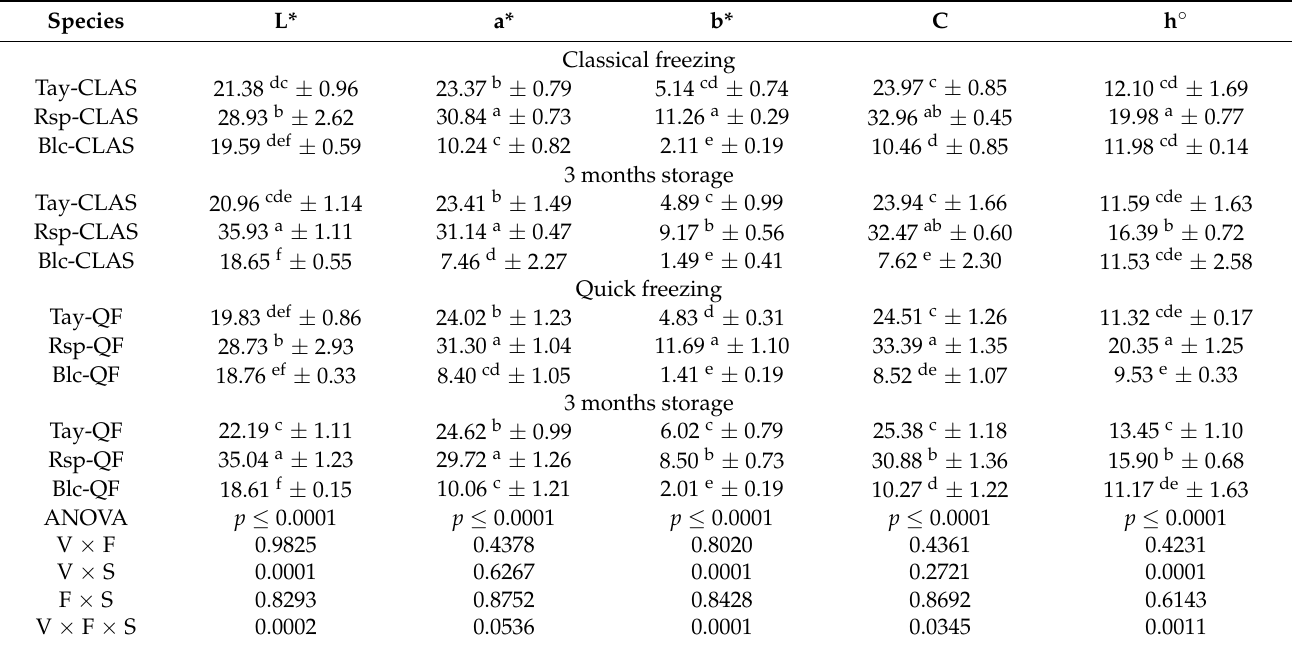
V × F—interaction of variety and freezing method; V × S—interaction between variety and storage; F × S—interaction of freezing method and storage; V × F × S—interaction of variety, freezing method and storage. Results are expressed as mean ± standard deviation. Different letters indicate significant differences between mean